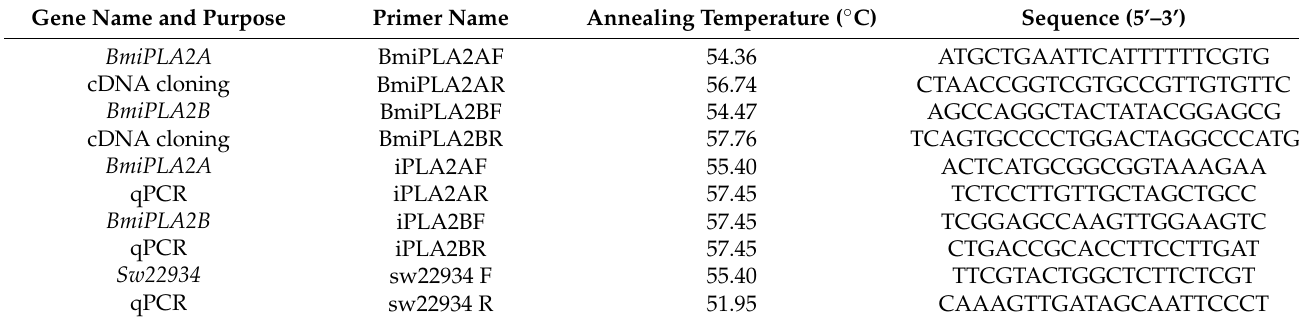
Table 1. Primers used in this